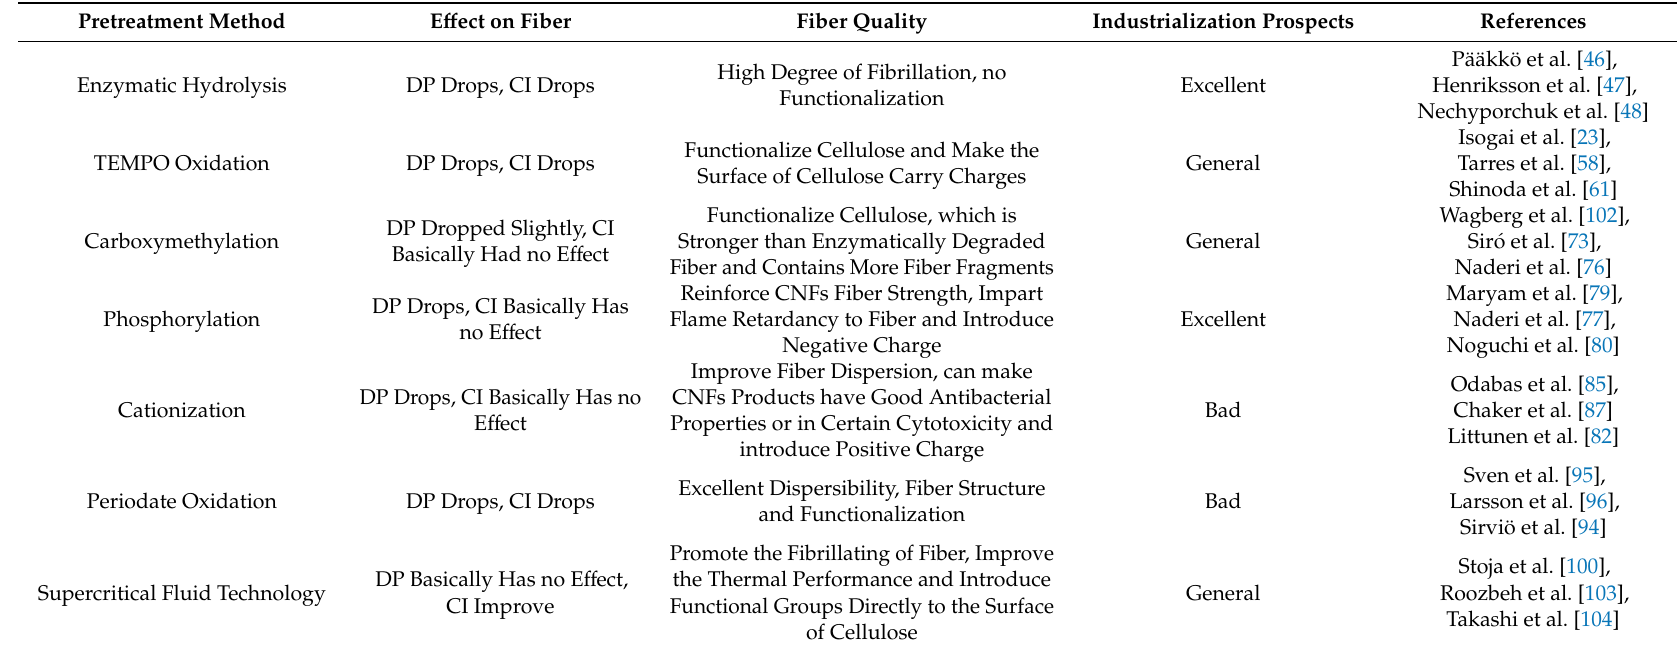
Table 3. Cellulose pretreatment